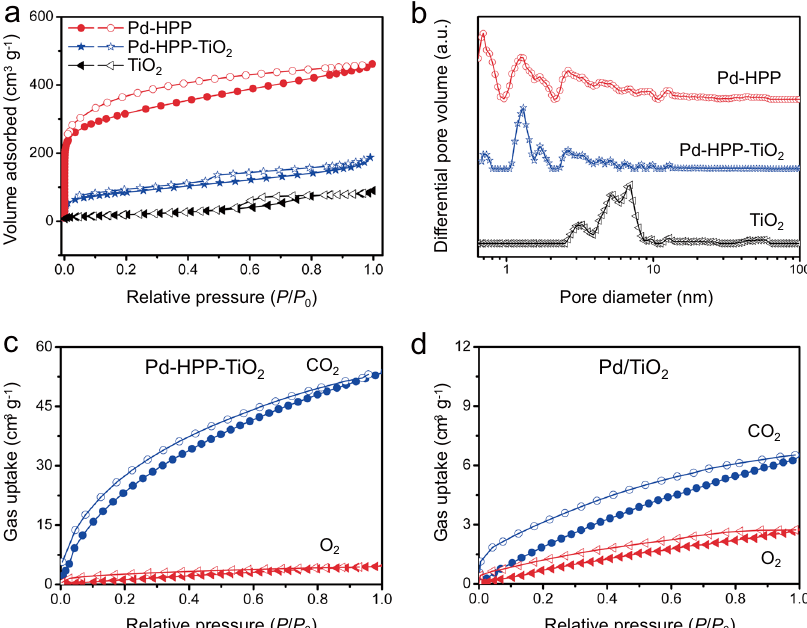
Fig. 3 Surface porosity and gas uptake. ( a ) N 2 adsorption-desorption isotherms and ( b ) pore size distribution plots of hollow TiO 2 , Pd-HPP, and Pd-HPP- TiO 2 . Comparisons in CO 2 and O 2 uptake of ( c ) Pd-HPP-TiO 2 and ( d ) Pd/TiO 2 at 273